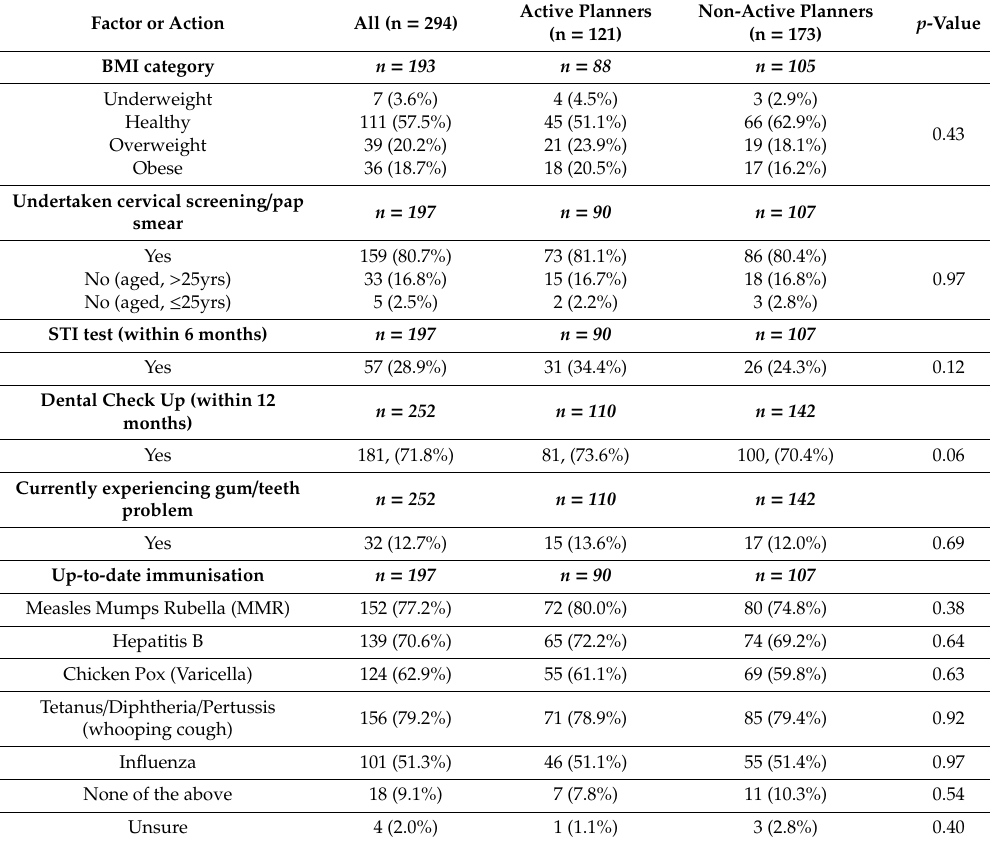
Table 3. General physical health and screening, stratified by pregnancy